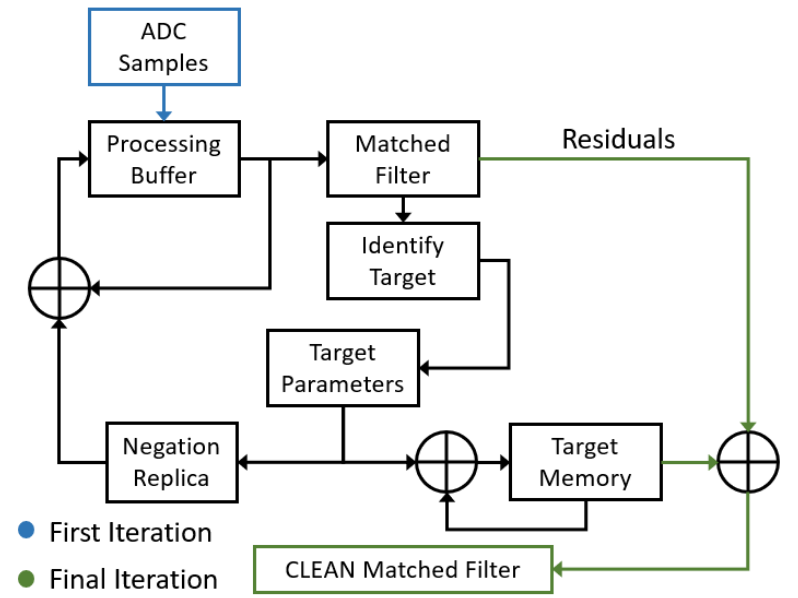
Figure 2. Simplified block diagram of a CLEAN algorithm.